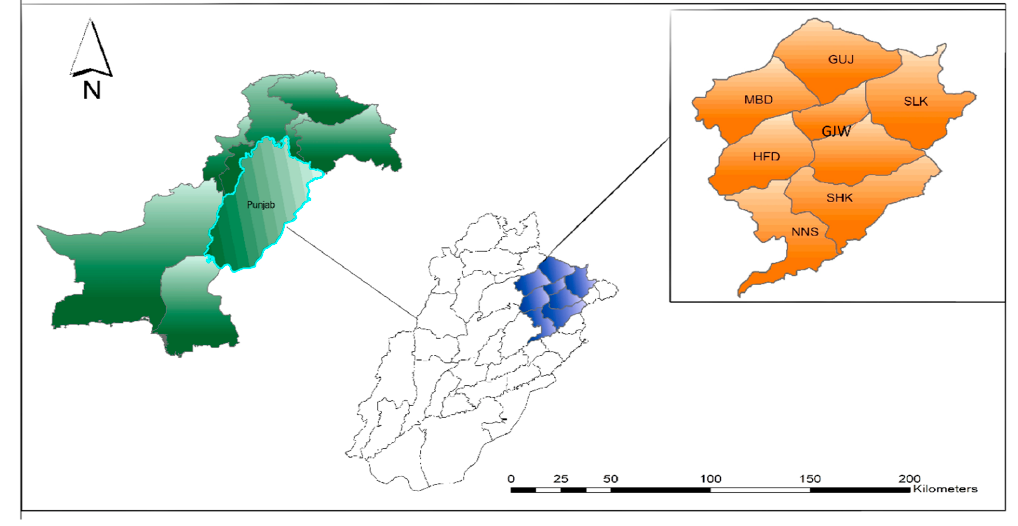
Figure 1. Study area map.